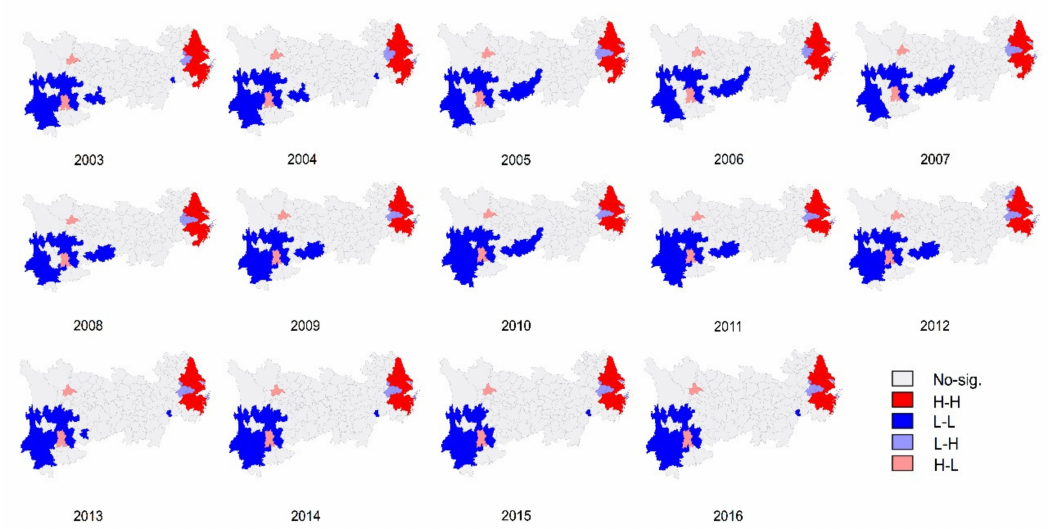
Figure 3. Temporal evolution of local Moran scatter plots of the GDP in the Yangtze River Economic Zone. Source: Designed by authors.